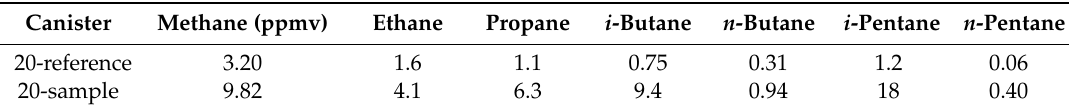
Table 2. Concentrations (in ppbv, except methane) for reference and sample canisters that were used to calculate sample number